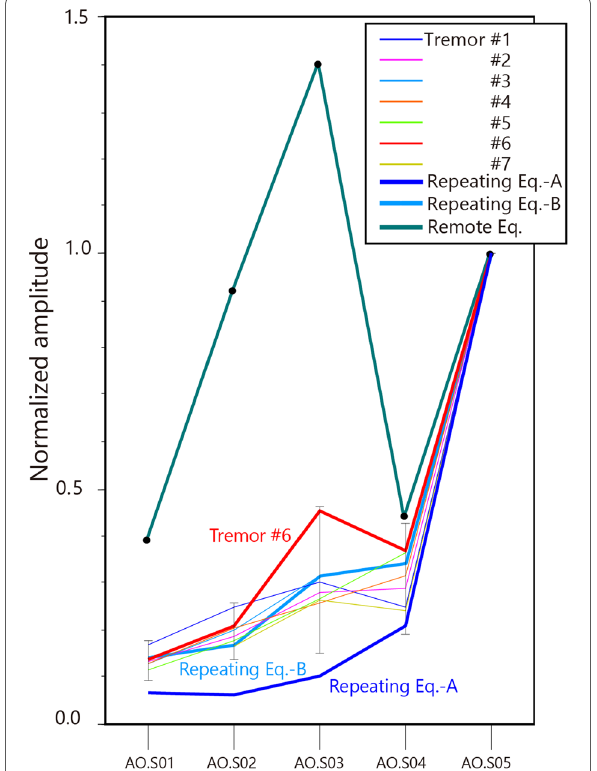
Fig. 4 Variation of maximum horizontal amplitude among the ocean-bottom seismometers (OBSs) stations. The maximum horizontal amplitudes in 2–4 Hz at four stations (AO.S01 to S04) are normalized to that at station AO.S05. Mean and standard deviations for the seven tremors are indicated by error bars